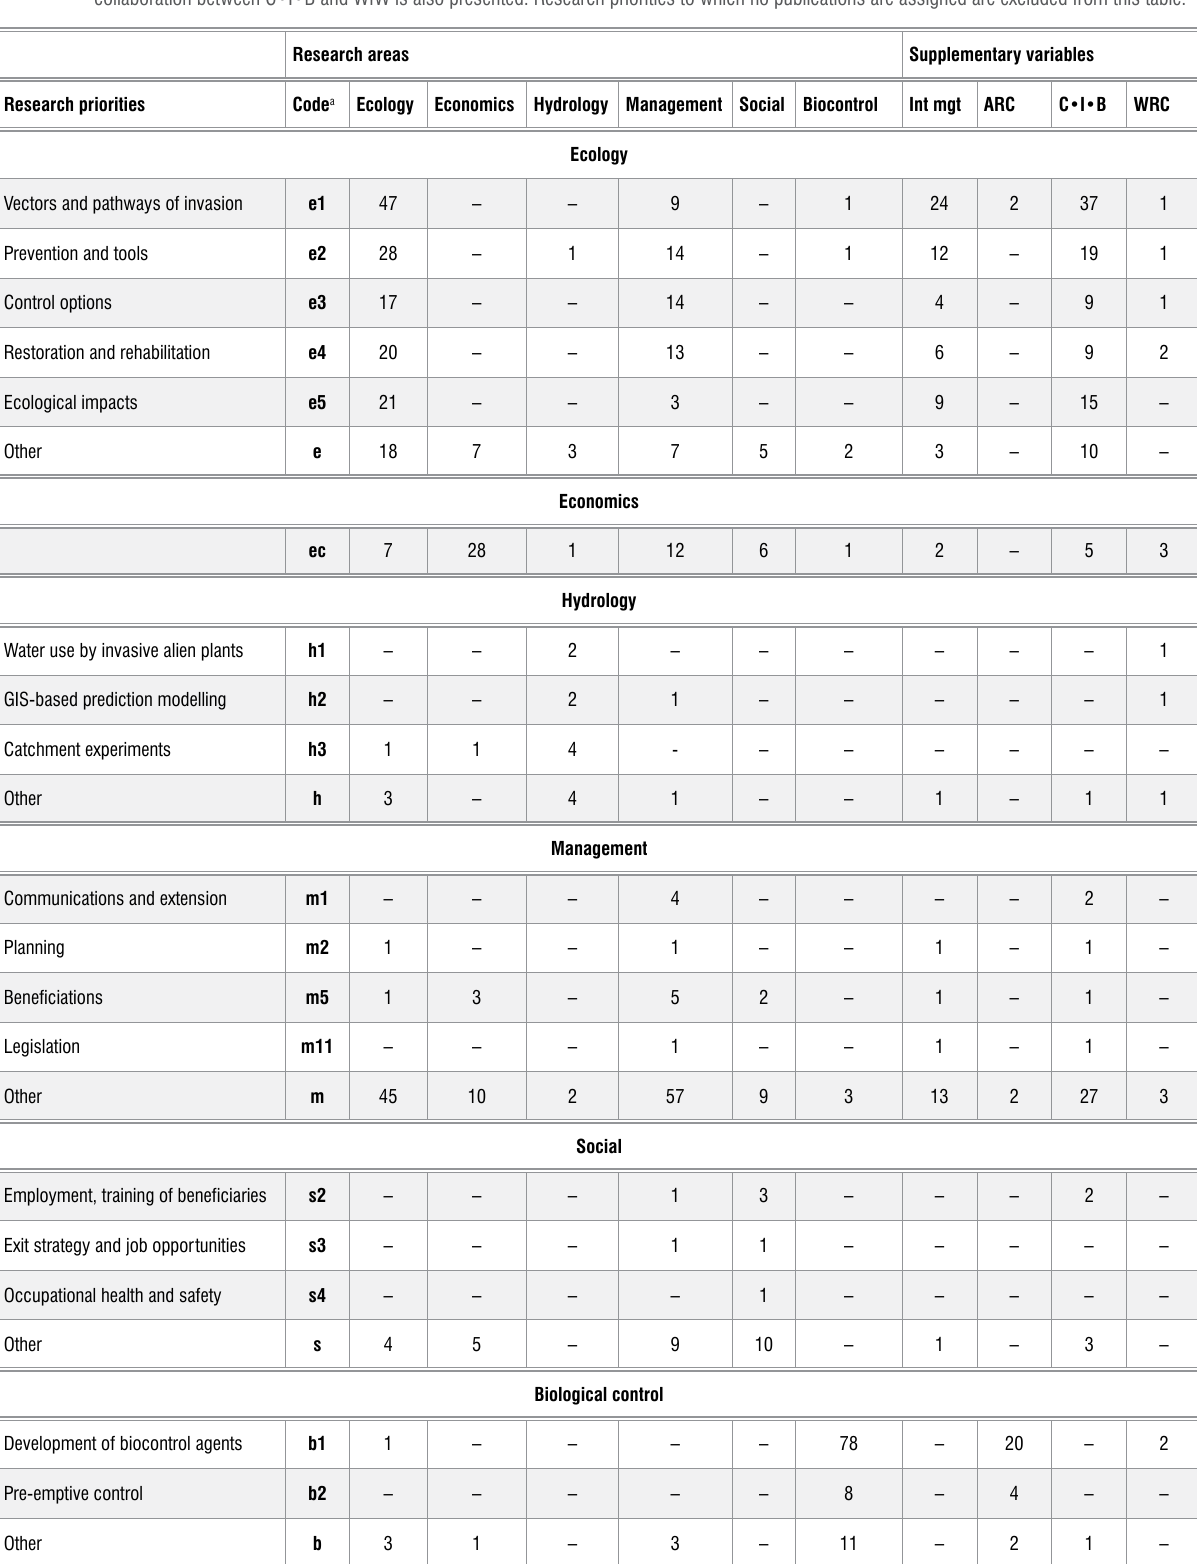
Table 3: The number of papers categorised according to research priorities under each research area, presented in Table 2. Supplementary variables represent funding organisations administering Working for Water funding: Centre for Invasion Biology (C•I•B), the Agricultural Research Council (ARC) and the Water Research Commission (WRC). Research funded through the ‘Integrated management of invasive alien species’ (Int mgt) collaboration between C•I•B and WfW is also presented. Research priorities to which no publications are assigned are excluded from this